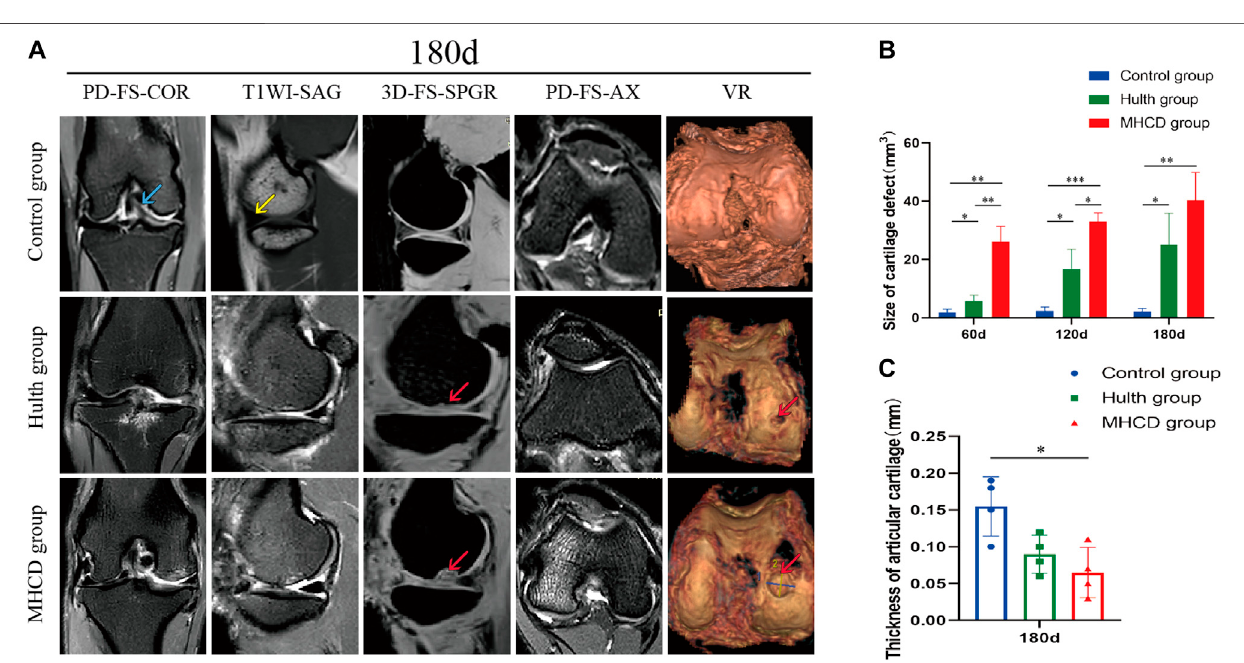
FIGURE 4 | MRI fi ndings of the knee joints of the three groups of rhesus macaques. (A) Representative MRI fi ndings of the knee joints on Day 180. (B) Sizes of articular cartilage defects on Days 60, 120, and 180. (C) Thicknesses of articular cartilage in the weight-bearing part of the knee joint on Day 180. (blue arrows, ACL; yellow arrows, medial meniscus; red arrows, cartilage defects). * p < 0.05, ** p < 0.01, *** p < 0.001. Data are presented as the mean ± SD.